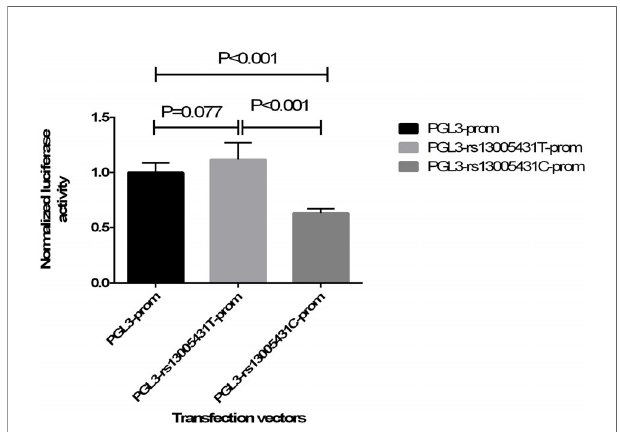
FIGURE 2 | Normalized luciferase activity of three transfection vectors. The relative luciferase activity is presented as the fi re fl y luciferase activity of each well divided by the Renilla luciferase activity. The normalized luciferase activity was expressed as a ratio to the mean relative luciferase activity of the PGL3- promoter group by each relative luciferase